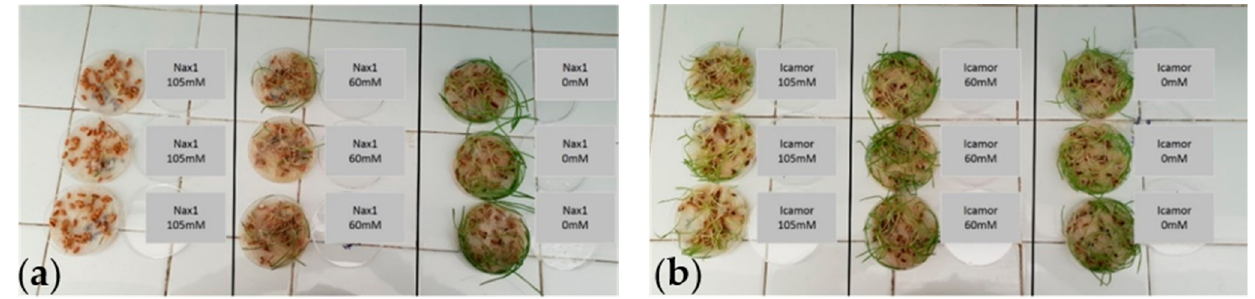
Figure 3. Germinated seeds of Icamor ( a ) and Nax1 ( b ) under salt concentrations of 0, 60, and 105 mM.